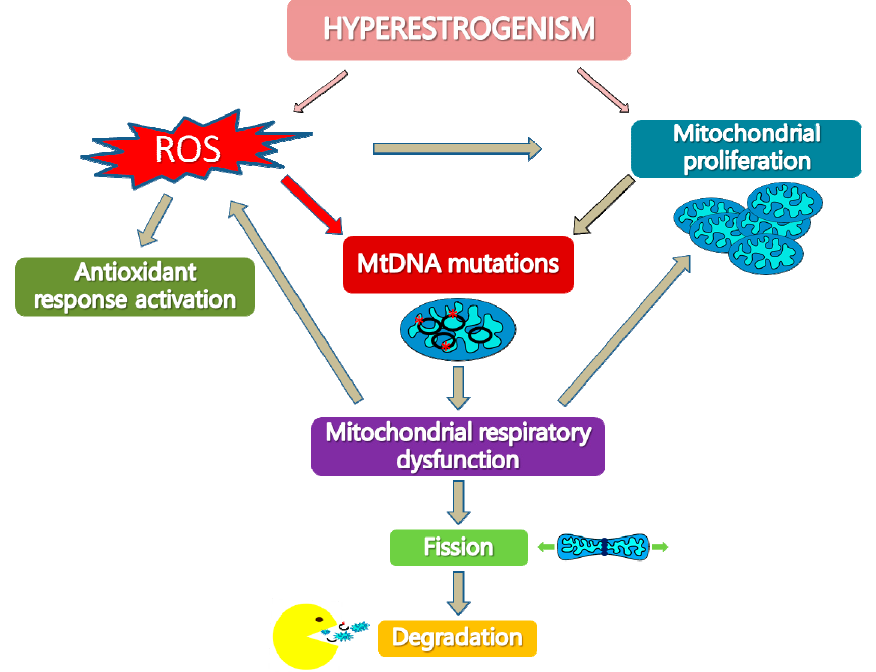
Figure 1. Hyperestrogenism and mitochondrial dysfunction in type I endometrial cancer. Hyperestrogenism may stimulate reactive oxygen species (ROS) production and increase mitochondrial